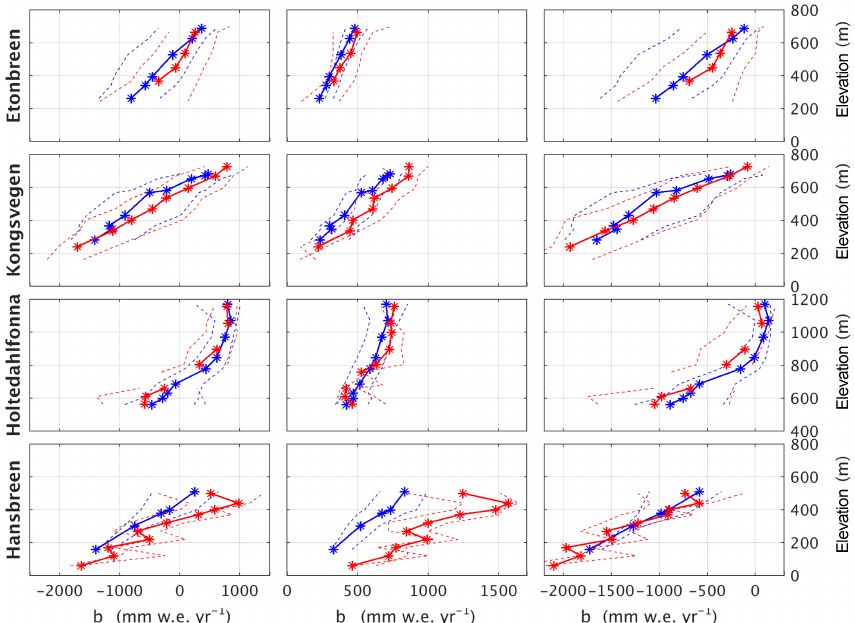
Figure 3. Simulated (blue) and observed (red) annual, winter, and summer mass balance at the four main validation glaciers. The 10-year mean is indicated by solid lines and the years 2004 and 2008 (negative and positive anomaly, respectively) are shown as dashed lines. Stars indicate elevation of individual stakes (red) or grid cells (blue).